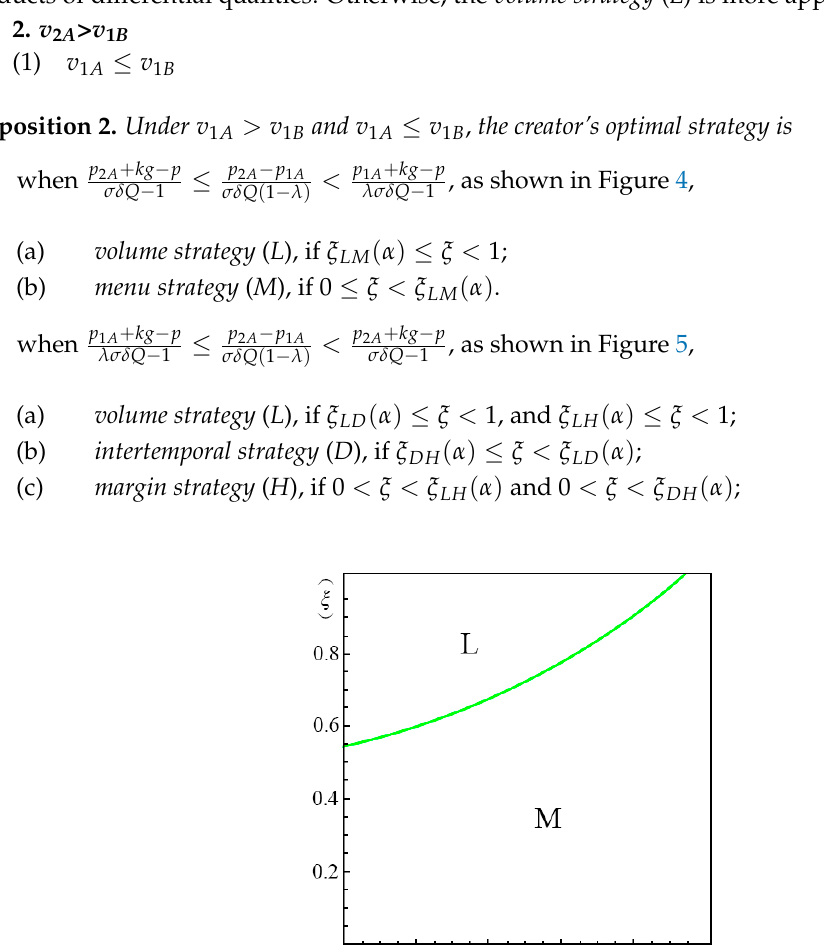
< p 1 A + kg − p (cid:3407) (cid:3043) (cid:3117)(cid:3250) (cid:3397)(cid:1863)(cid:1859) (cid:2879)(cid:3043) λσδ Q − 1 (cid:3090)(cid:3097)(cid:3083)(cid:3018)(cid:2879)(cid:2869)